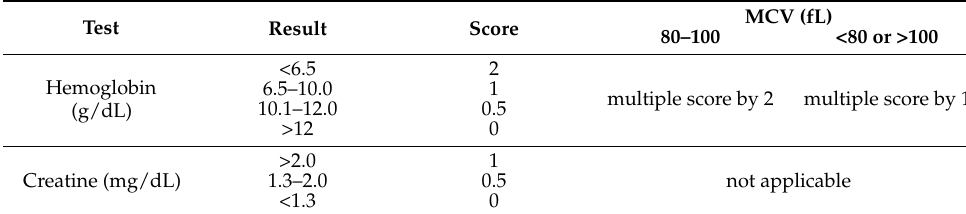
Table 3. Additional score dependent on the presence of laboratory test results: concentration of hemoglobin, mean corpuscular volume, and hemoglobin.